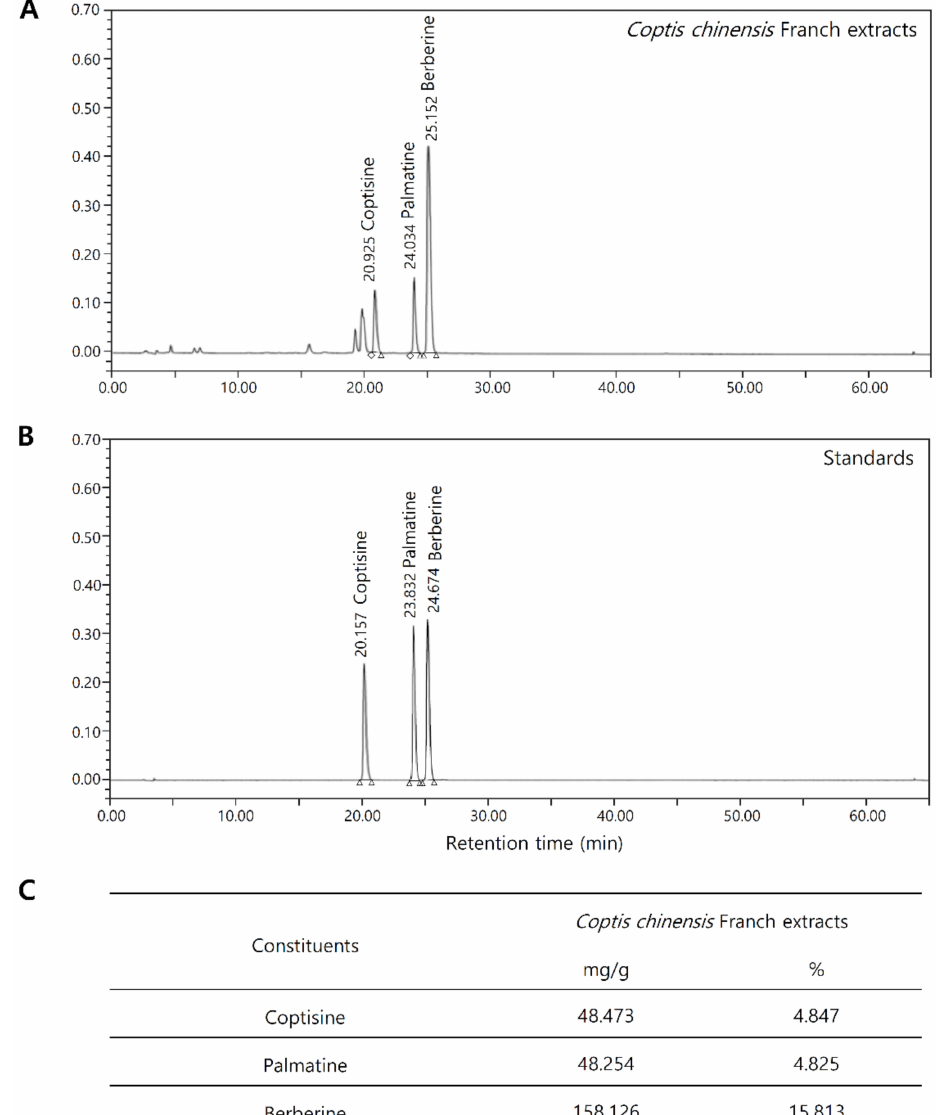
Figure 1. Composition of Coptis chinensis Franch extract (CCE). ( A , B ) Phytochemical analysis of CCE. ( C ) Quantitative analysis of the phytochemical activity of